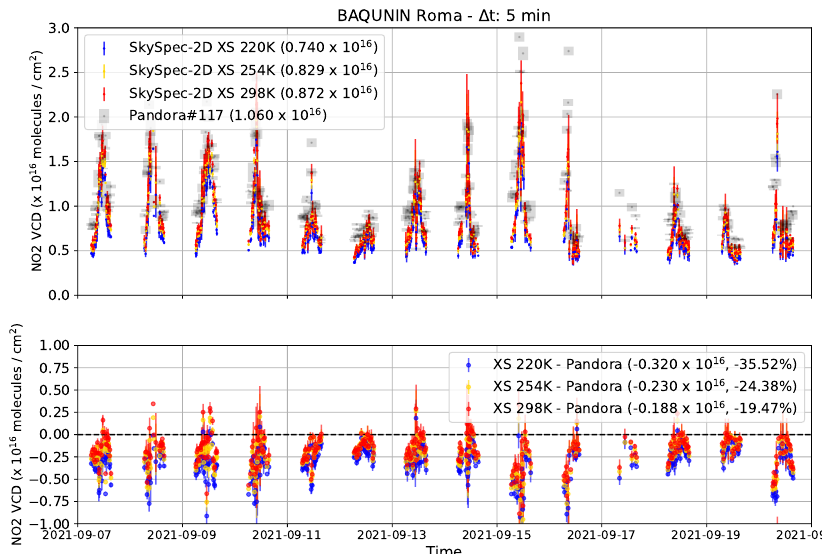
Figure 9. NO 2 VCDs retrieved from SkySpec-2D with NO 2 cross sections at different temperatures (220 K in blue, 254.5 K in yellow, 298 K in red) and Pandora#117 (grey shadow) during the BAQUNIN inter-comparison campaign, results and absolute differences. Data are averaged in 5 min intervals.